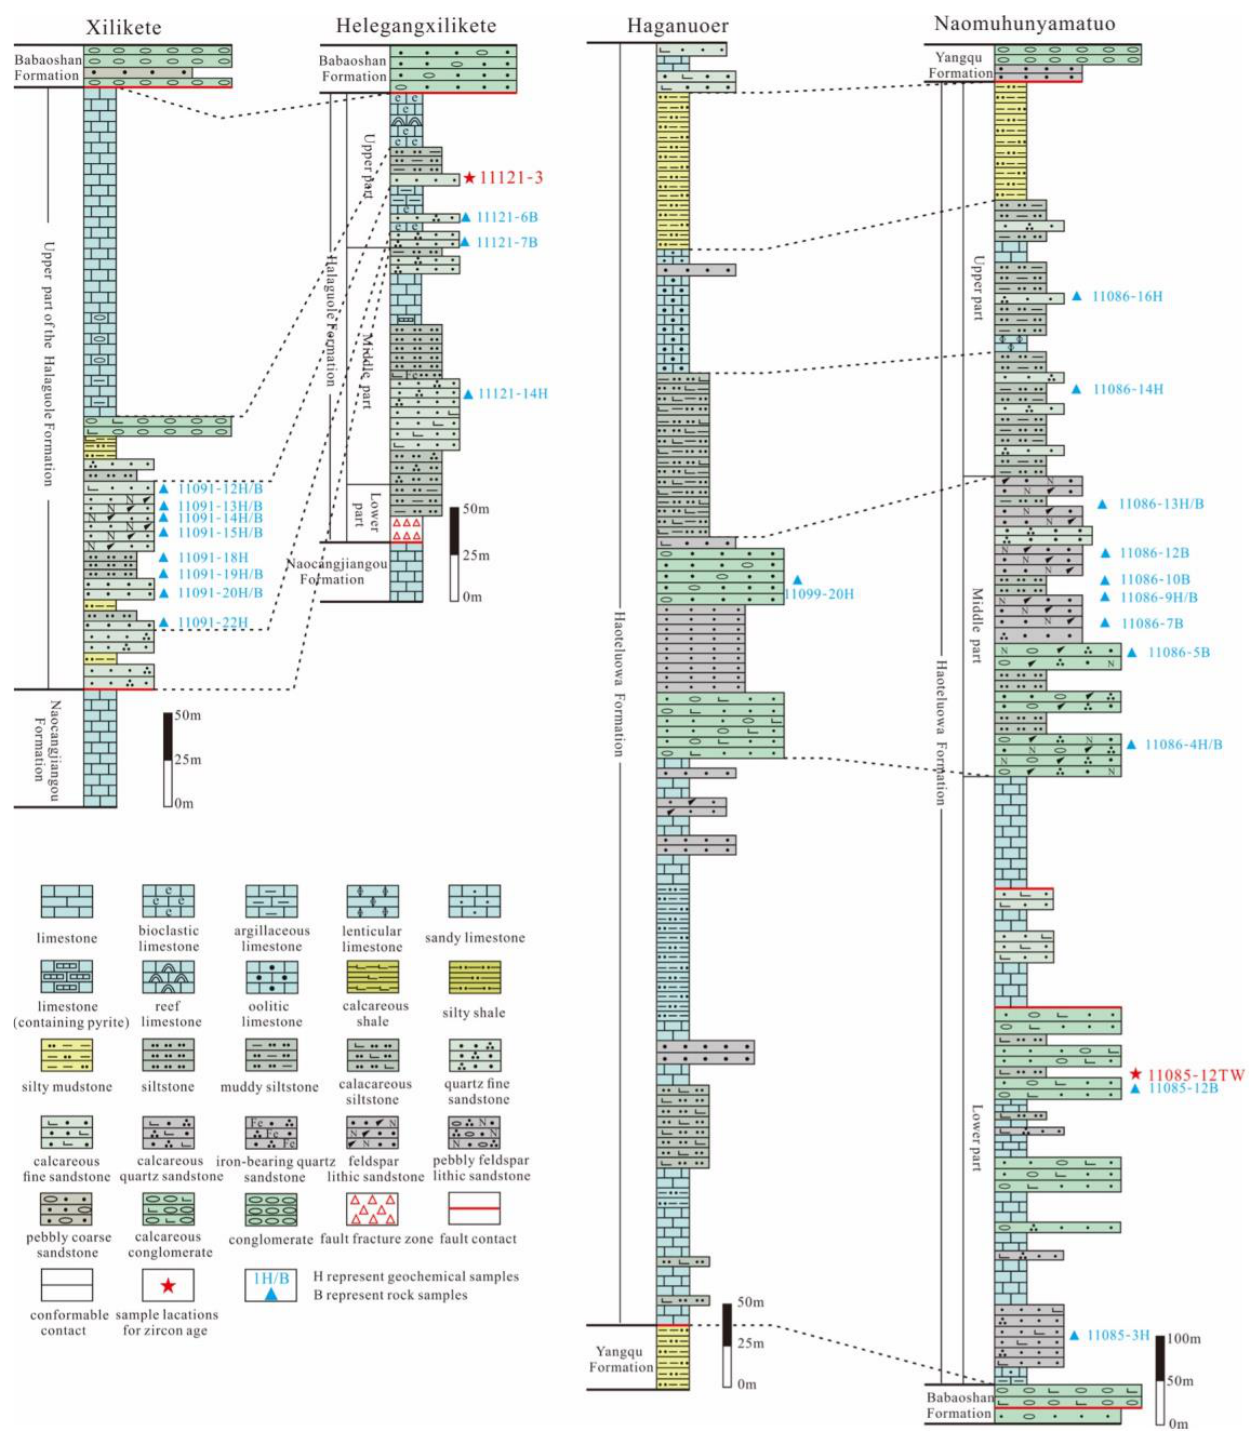
Figure 2. Measured sections of Carboniferous succession in Alake Lake, eastern EKO. Location of sections are shown in Figure 1c.